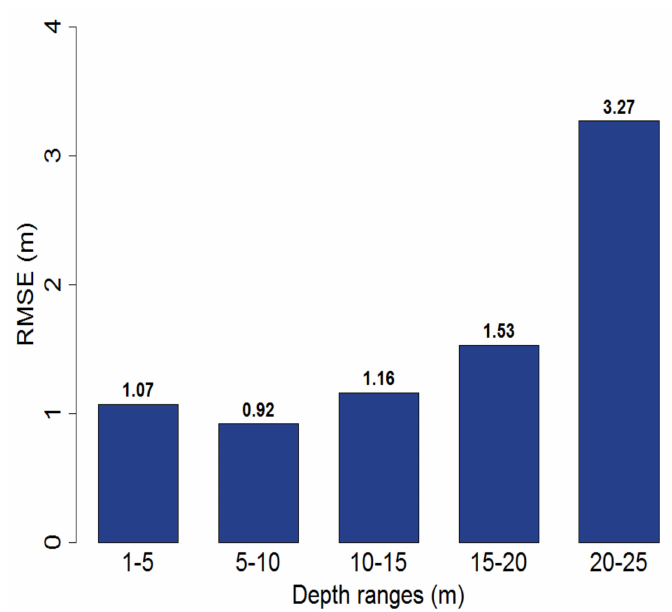
Figure 8. RMSE values obtained for the ensemble-based SDB estimates at di ff erent water